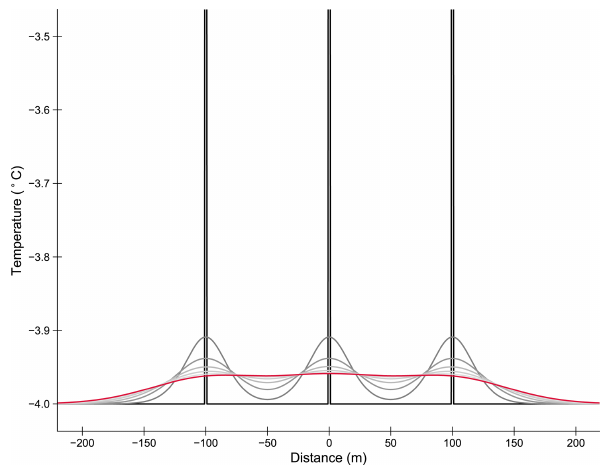
Figure 7. Evolution of a synthetic 1-D temperature field from basal crevasses spaced 100m apart. Temperatures are plotted every 5 years, and older temperature fields are shaded darker shades of grey. The red line shows the temperature field 30 years after refreezing. Distinct crevasses can cause cooling over large regions of the